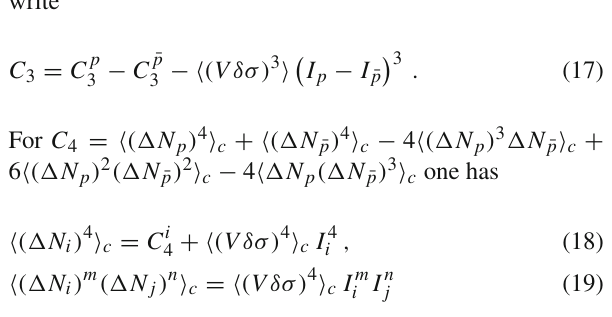
Fig. 1 Sketch of the set-up in the QCD phase diagram considered in this work. The filled band between the two dashed curves comprises available information from lattice QCD on the crossover region as known for small μ B , which we extrapolate to larger μ B . The dashed curves areobtainedbysolvingEq.(21)toleadingorderwith κ c = 0 . 007 ( upper curve , T c , 0 = 0 . 163 GeV) and κ c = 0 . 02 ( lower curve , T c , 0 = 0 . 145 GeV). The location of the critical point and of the adja- cent first-order phase transition is not known. The placement in this figure corresponds to the choice of parameters specified in Sect. 3.2. The spin model coordinate system ( r , h ) has its origin in the critical point. Details of the mapping are described in the text. We also show the chemical freeze-out conditions determined in [40] ( squares ) and a practical parametrization of these results ( solid curve ), which is dis- cussed in Appendix